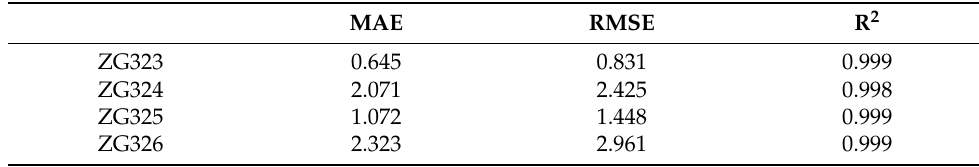
Figure 8. ( a ) Predicted and observed trend displacement in the test set of ZG323; ( b ) predicted and measured trend displacement of ZG324; ( c ) predicted and measured trend displacement of ZG325; ( d ) predicted and measured trend displacement of ZG326. Table 3. The predicted accuracy for the training